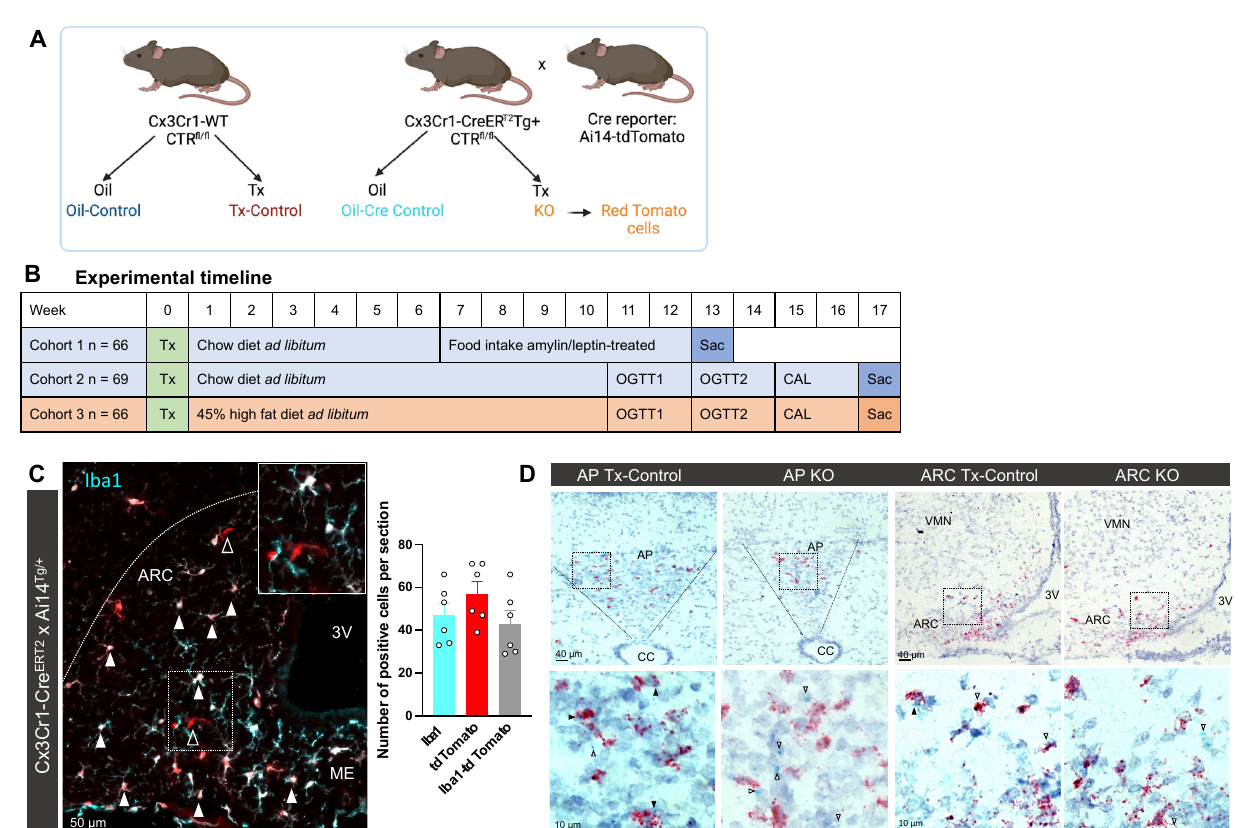
Figure 1. Specific expression of functional Cre recombinase after tamoxifen induction. ( A ) For metabolic phenotype studies, three cohorts of Cx3Cr1-Cre ERT2 mice were bred with CTR fl/fl mice; ( B ) Mice were tamoxifen (Tx) induced at ≥ 56 day of age and fed ad libitum chow or 45% high-fat diet for several weeks before experiments. ( C ) Cx3Cr1-Cre ERT2 mice were crossed with an Ai14 tdTomato Cre-reporter line that expresses a STOP-floxed tdTomato allele. Immunohistochemistry with Iba1 antibody reveals a near-perfect overlap of Iba1 (cyan) with tdTomato (red) that results in a white color (filled arrowheads) with a few microglia only expressing tdTomato (empty arrowheads). ( D ) The model was further verified with Basescope in situ hybridization showing no CTR on microglia cells (empty arrowheads) in KO mice while Iba1 ‐ CTR colocalization was detected in Tx ‐ control mice (filled arrowheads). ARC: Arcuate nucleus; ME: Median eminence; 3V: Third ventricle; CC: Central canal; AP: Area Postrema; OGTT: Oral glucose tolerance test; CAL: Indirect calorimetry, SAC: Sac ‐ rifice.